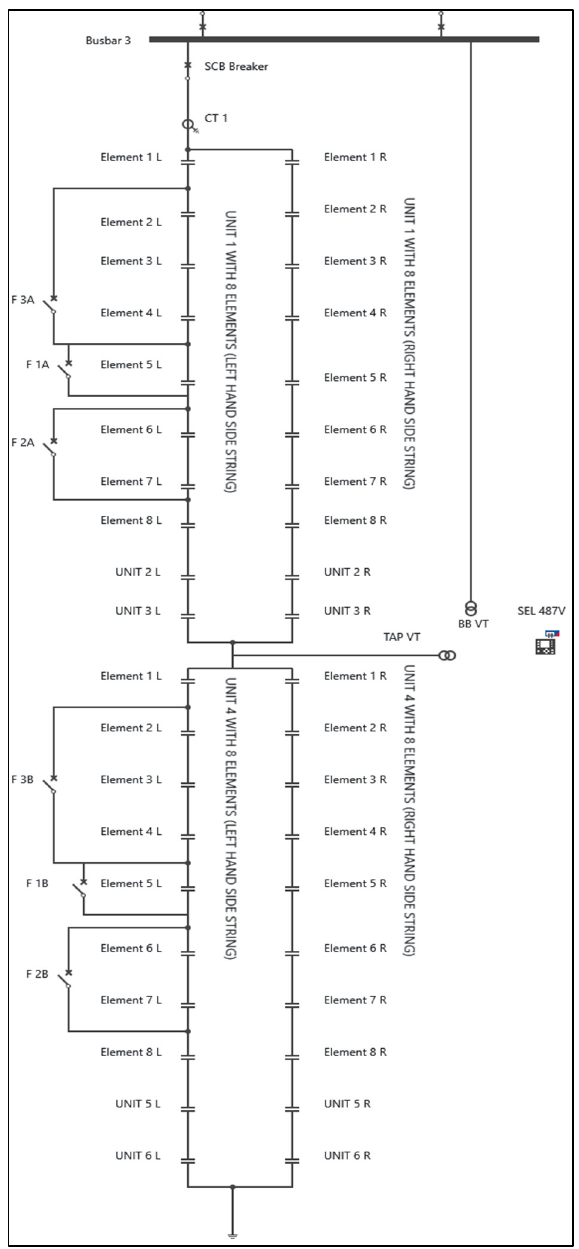
Figure 3. RelaySimTest was used to create a Capacitor Bank Model.